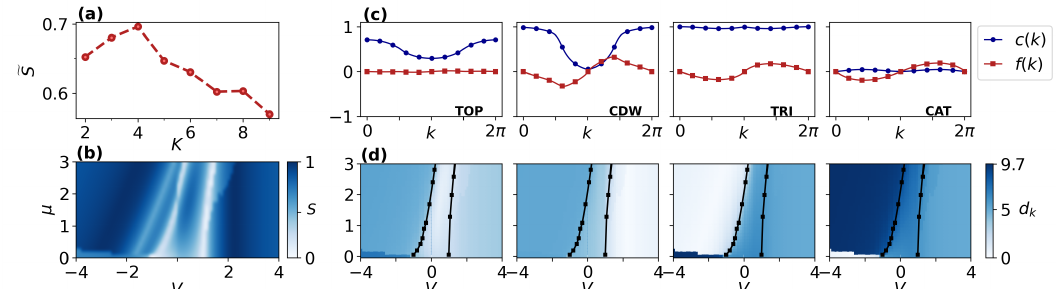
Figure 5: Interacting Hamiltonian: k-means clustering (a) Values of the silhouette score (cid:101) S as a function of the number of clusters K . The peak is at K = 4 in accordance to the 4 phases of the original phase diagram. (b) Reconstructed phase diagram of the interacting model (with K = 4 centroids) through the average silhouette value of every data point. Critical lines separating the phases are clearly visible, CAT phase is also highlighted. (c) Centroids obtained by applying k-means algorithm with K = 4. Every centroid resembles the correlation functions of the four different phases, as indicated by the label in the bottom right corner. (d) Distances of the correlation functions for each point of the phase diagram from the corresponding centroid (plot- ted in the panel above). The points belonging to the same phase show minimal distance to the same